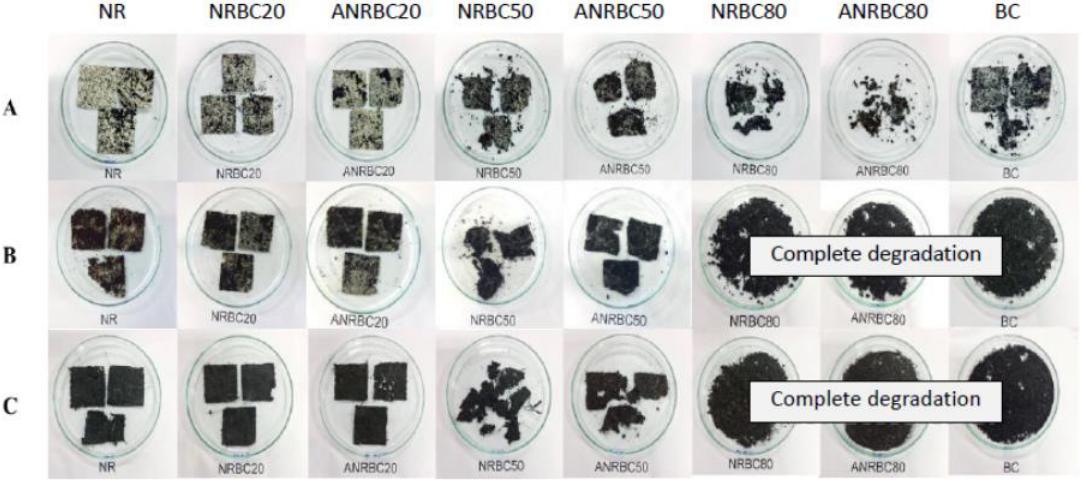
Figure 10. Biodegradation in soil of NR, BC, NRBC, and ANRBC films for 1 month ( A ), 3 months ( B ), and 6 months ( C ).